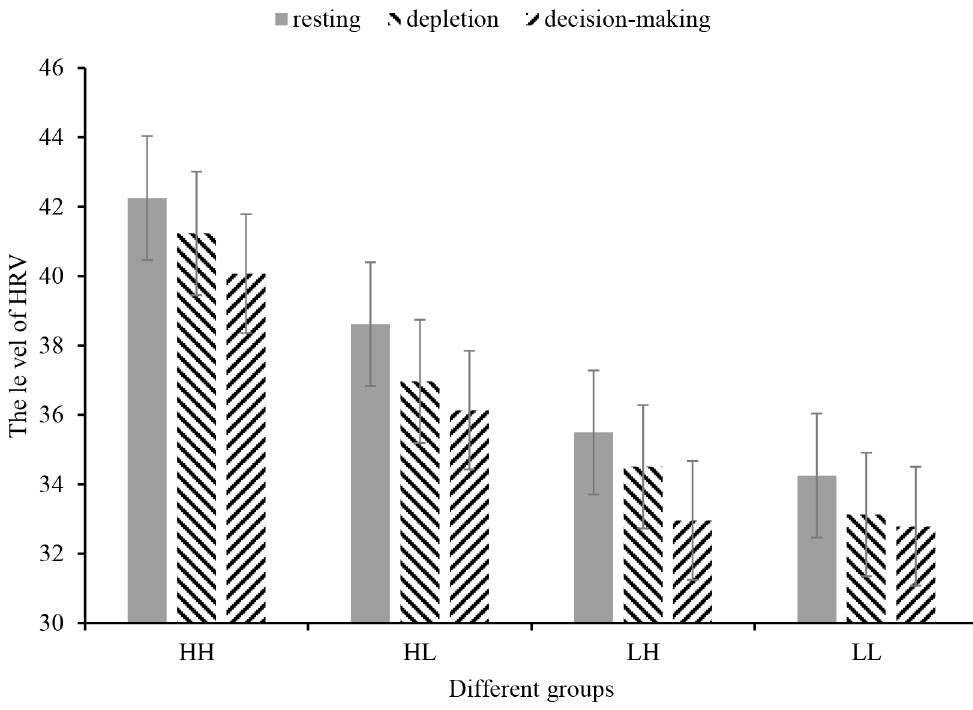
Fig 5. HRV among different groups in different experimental